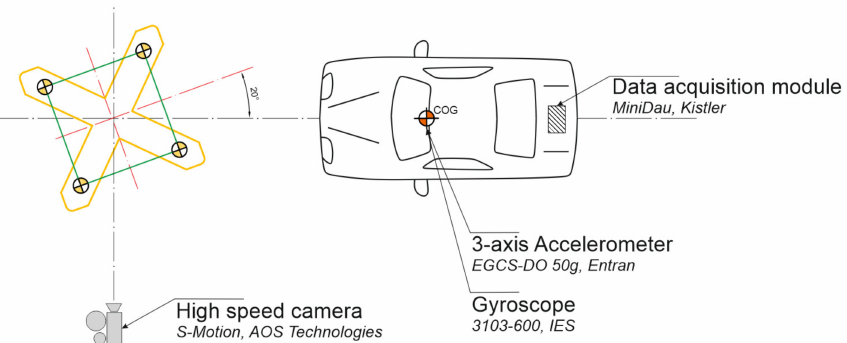
Figure 4. A scheme of mutual location of the supporting mast, the vehicle and measuring instrumen- tation.